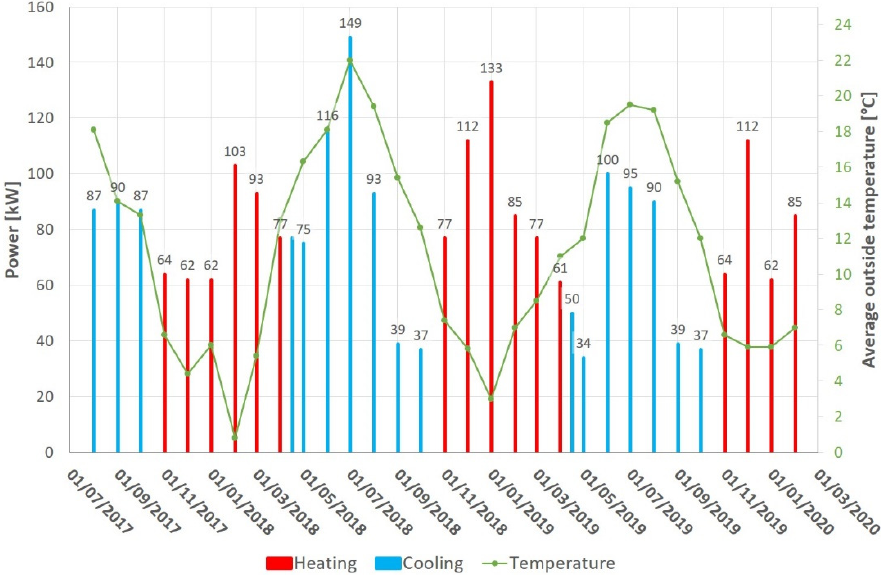
Figure 7. Power derived from groundwater by the ATES system of Building n° 2. Table 2. Heat transport parameters values introduced in the model [1,2,7,8].